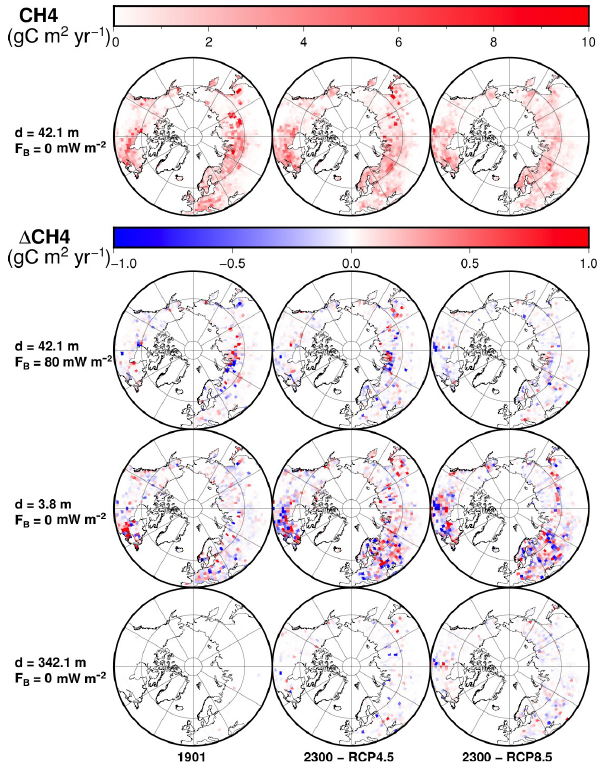
Figure 18. Distribution of methane yearly production for the orig- inal model (top row) and differences to the original model at each time frame for the modified model with 80mWm − 2 (second row), the modified model with d = 3 . 8m (third row) and the modified model with d = 342 . 1m (bottom row). Time frames are shown for 1901 and 2300CE for the RCP4.5 and RCP8.5